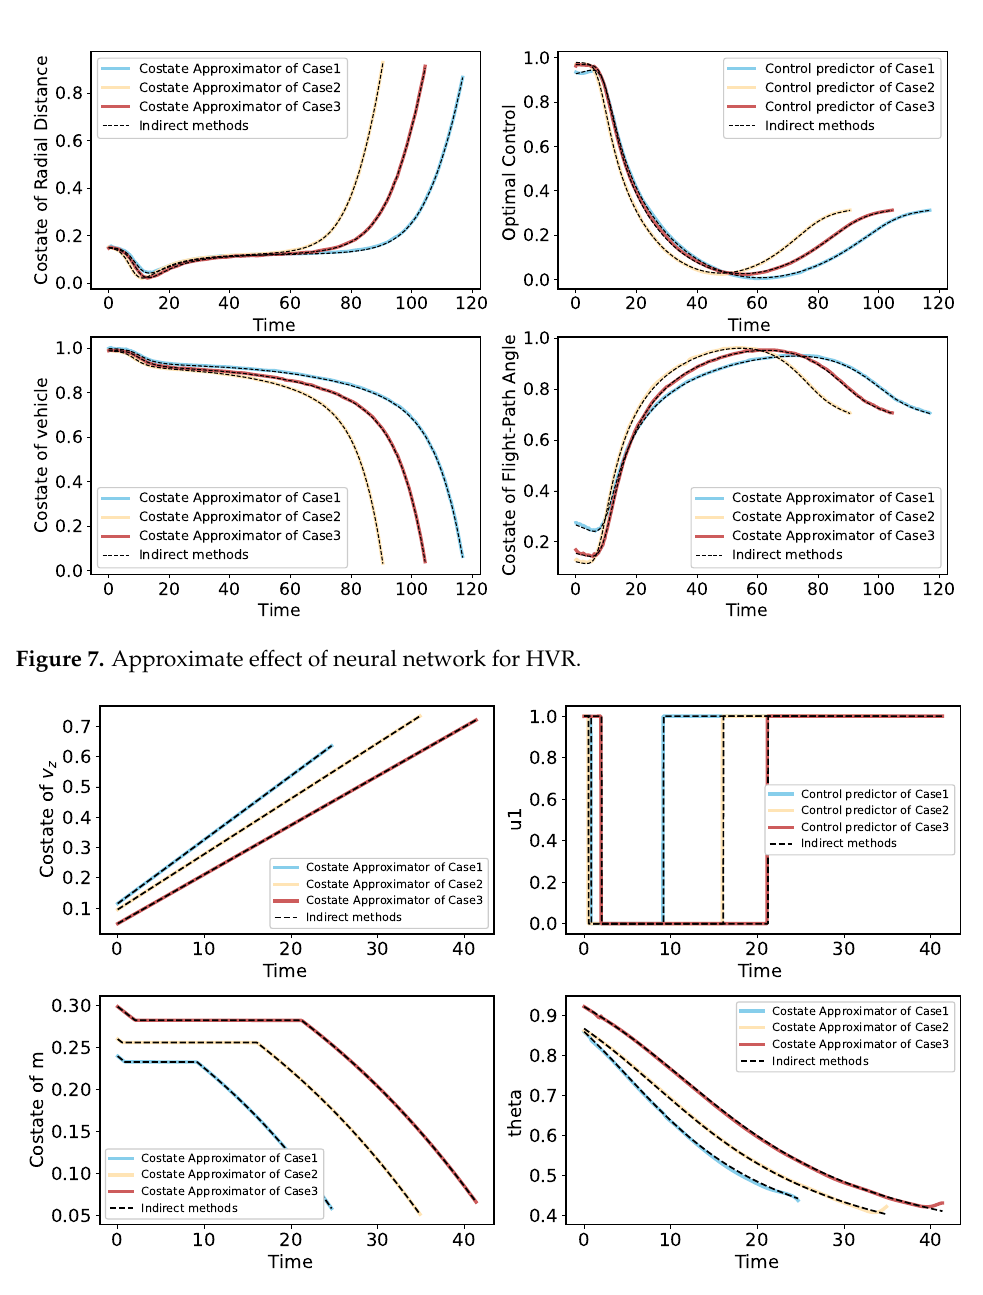
Figure 8. Approximate effect of neural network for